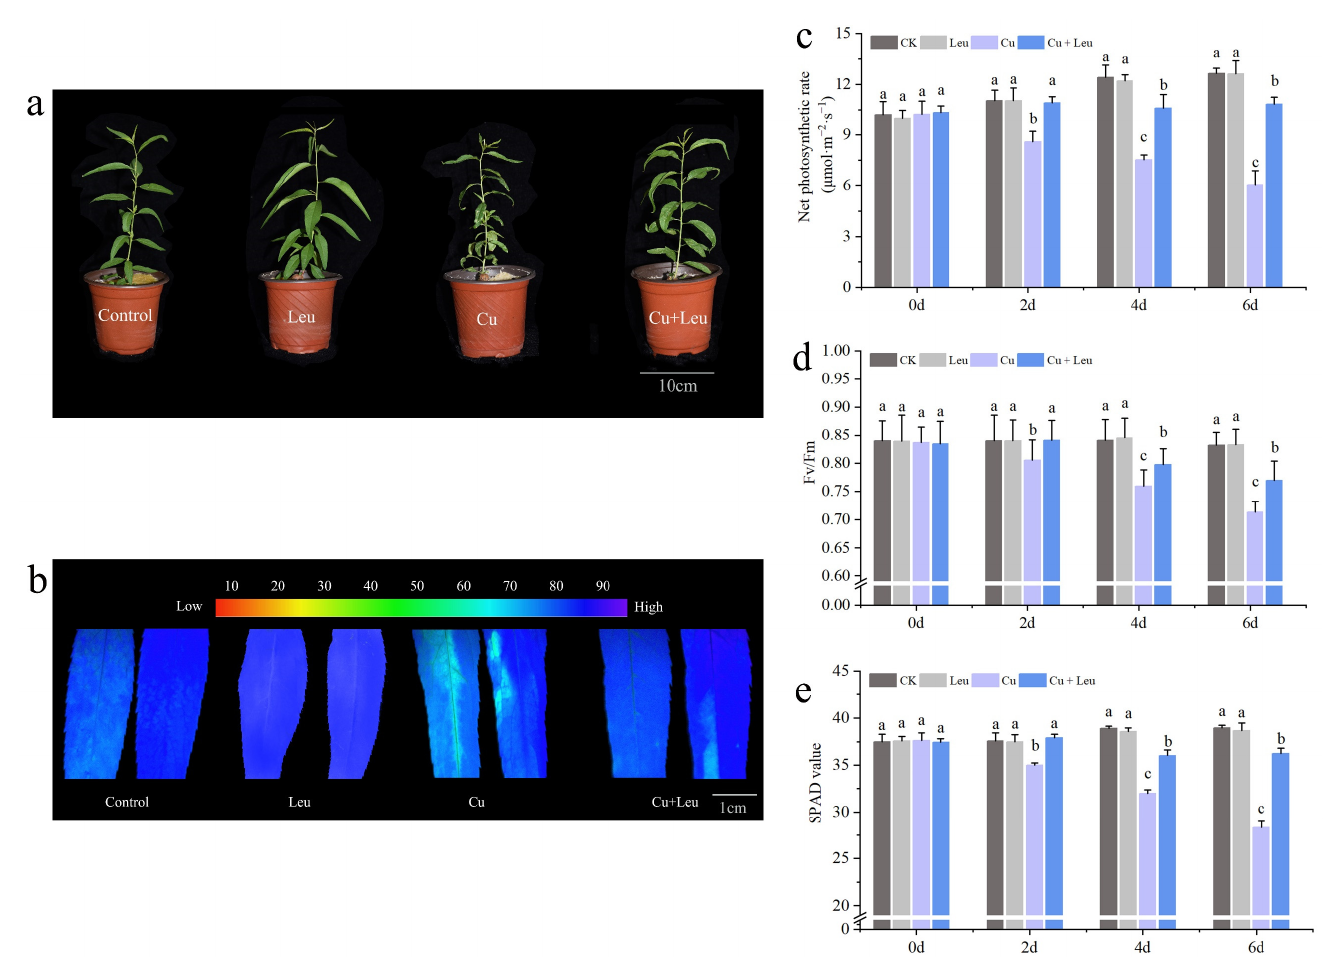
Figure 1. Effects of different treatments on growth, chlorophyll fluorescence imaging, net photosynthetic rate, SPAD value, and maximum photochemical efficiency of peach seedlings. ( a ) Peach seedlings under different treatments; ( b ) chlorophyll fluorescence imaging; ( c ) net photosynthetic rate; ( d ) SPAD value; ( e ) maximum photochemical efficiency. Each data point represents the mean ( ± SD) of three replicates. Error bars represent standard deviations of the means ( n = 3). Different lowercase letters indicate significant differences among different treatments (Duncan test, p < 0.05).